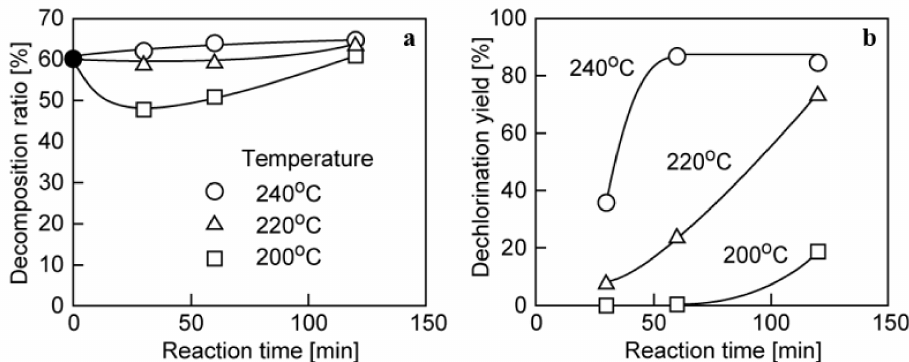
Figure 5. ( a ) Decomposition and ( b ) dechlorination ratios of PVC-P; PVC/glycerol mass ratio = 2/3.